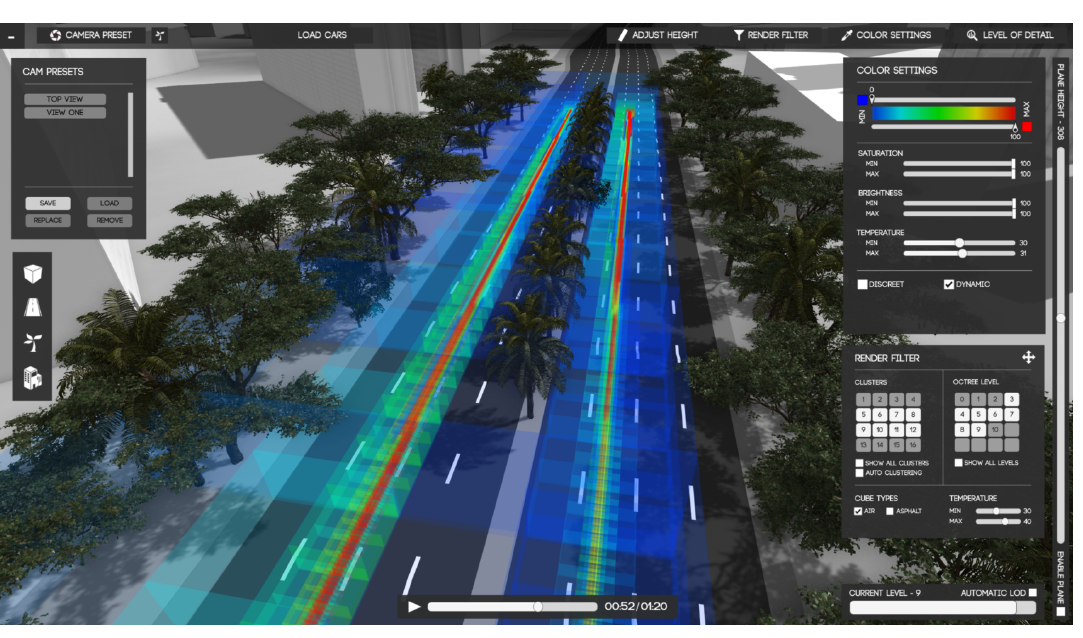
Figure 12. CityHeat visualization tool for microscopic simulation and analysis of traffic heat on a three-dimensional virtual city environment [54] (extracted from